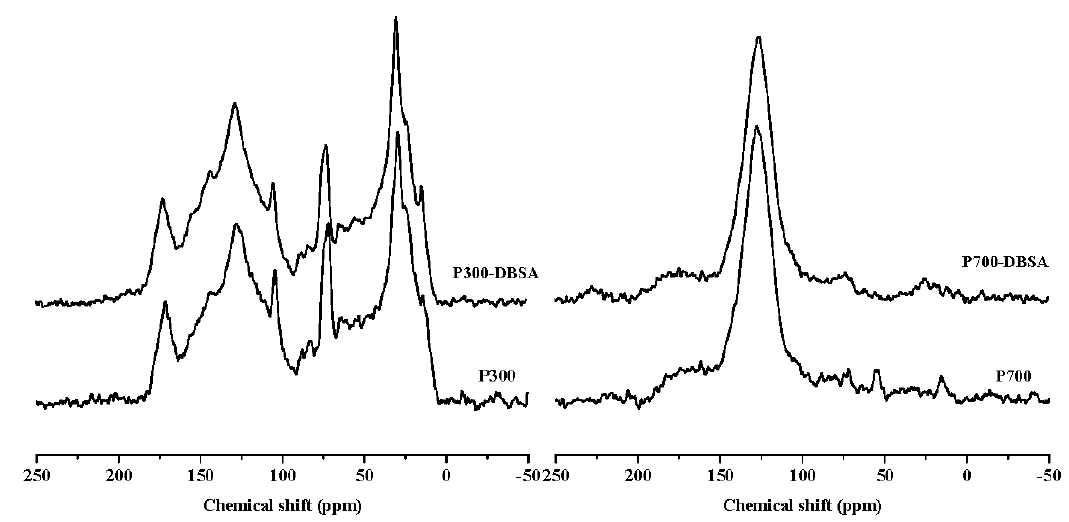
Figure 8. 13 C-NMR spectra of poplar leaf biochars and their interaction complexes.